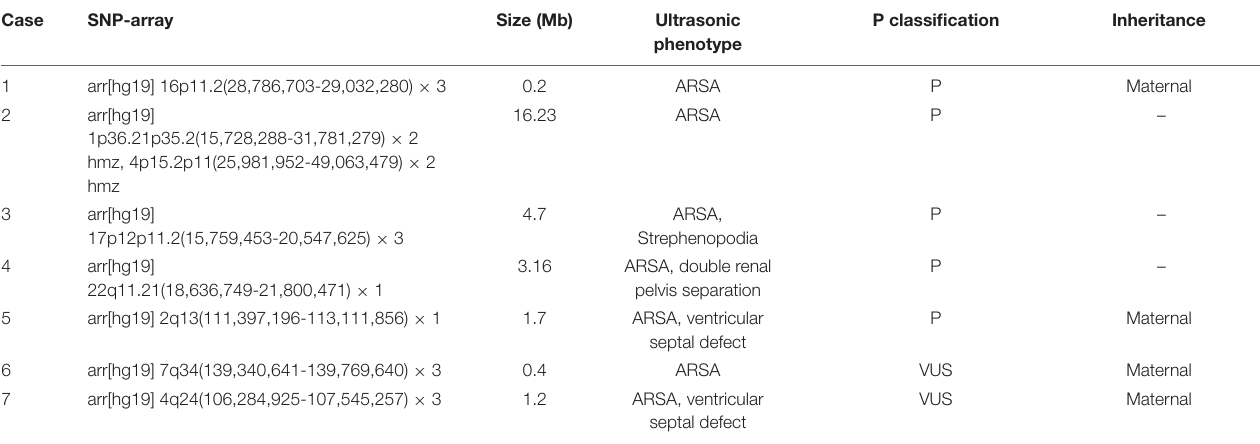
TABLE 3 | Single-nucleotide polymorphism-array detected in fetuses with ARSA.